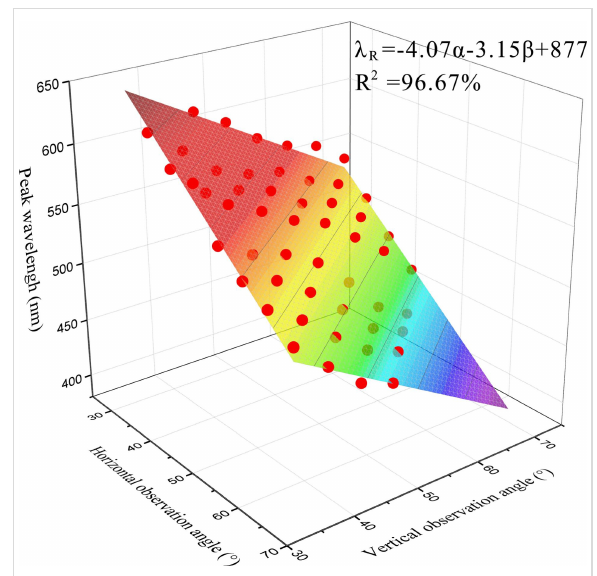
Figure 5: The three-dimensional function of the reflection wavelength peak and observation